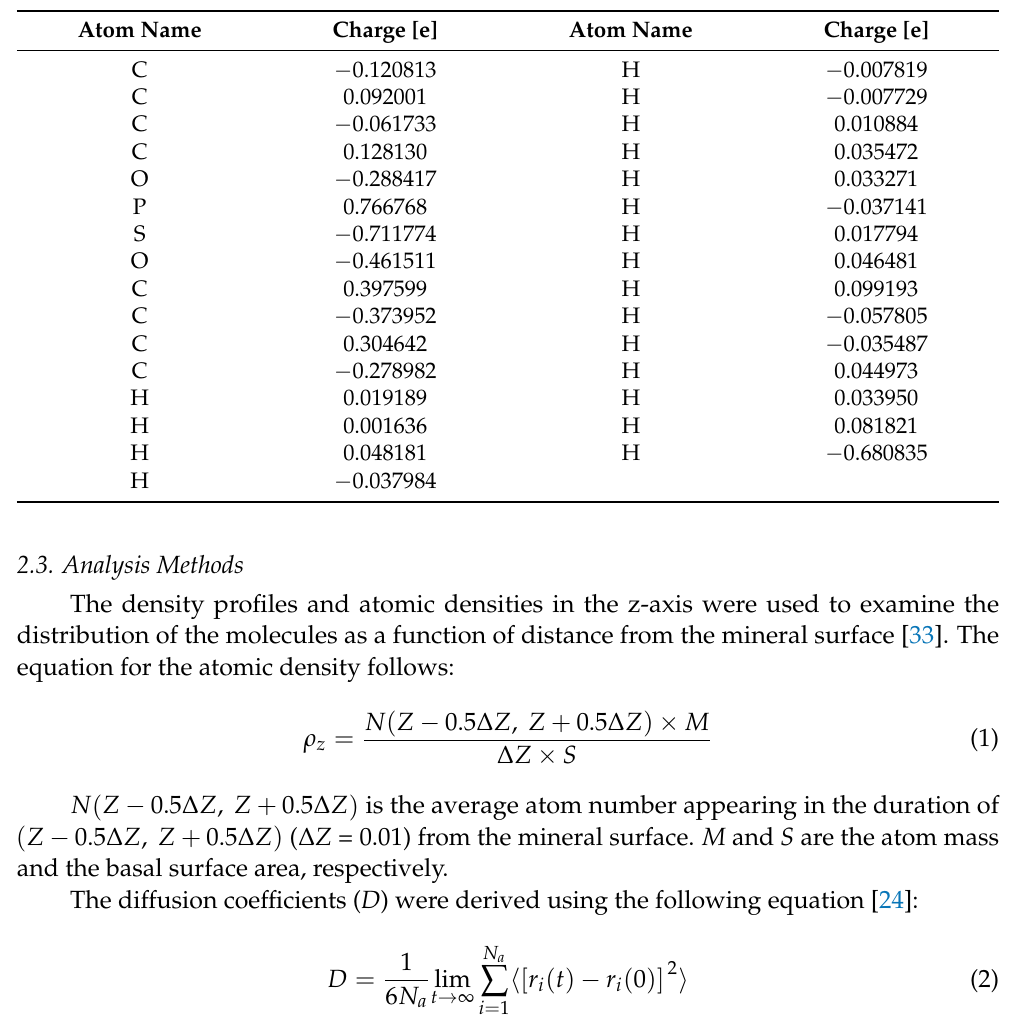
Table 4. Gaussian calculated charge parameters for the MTP